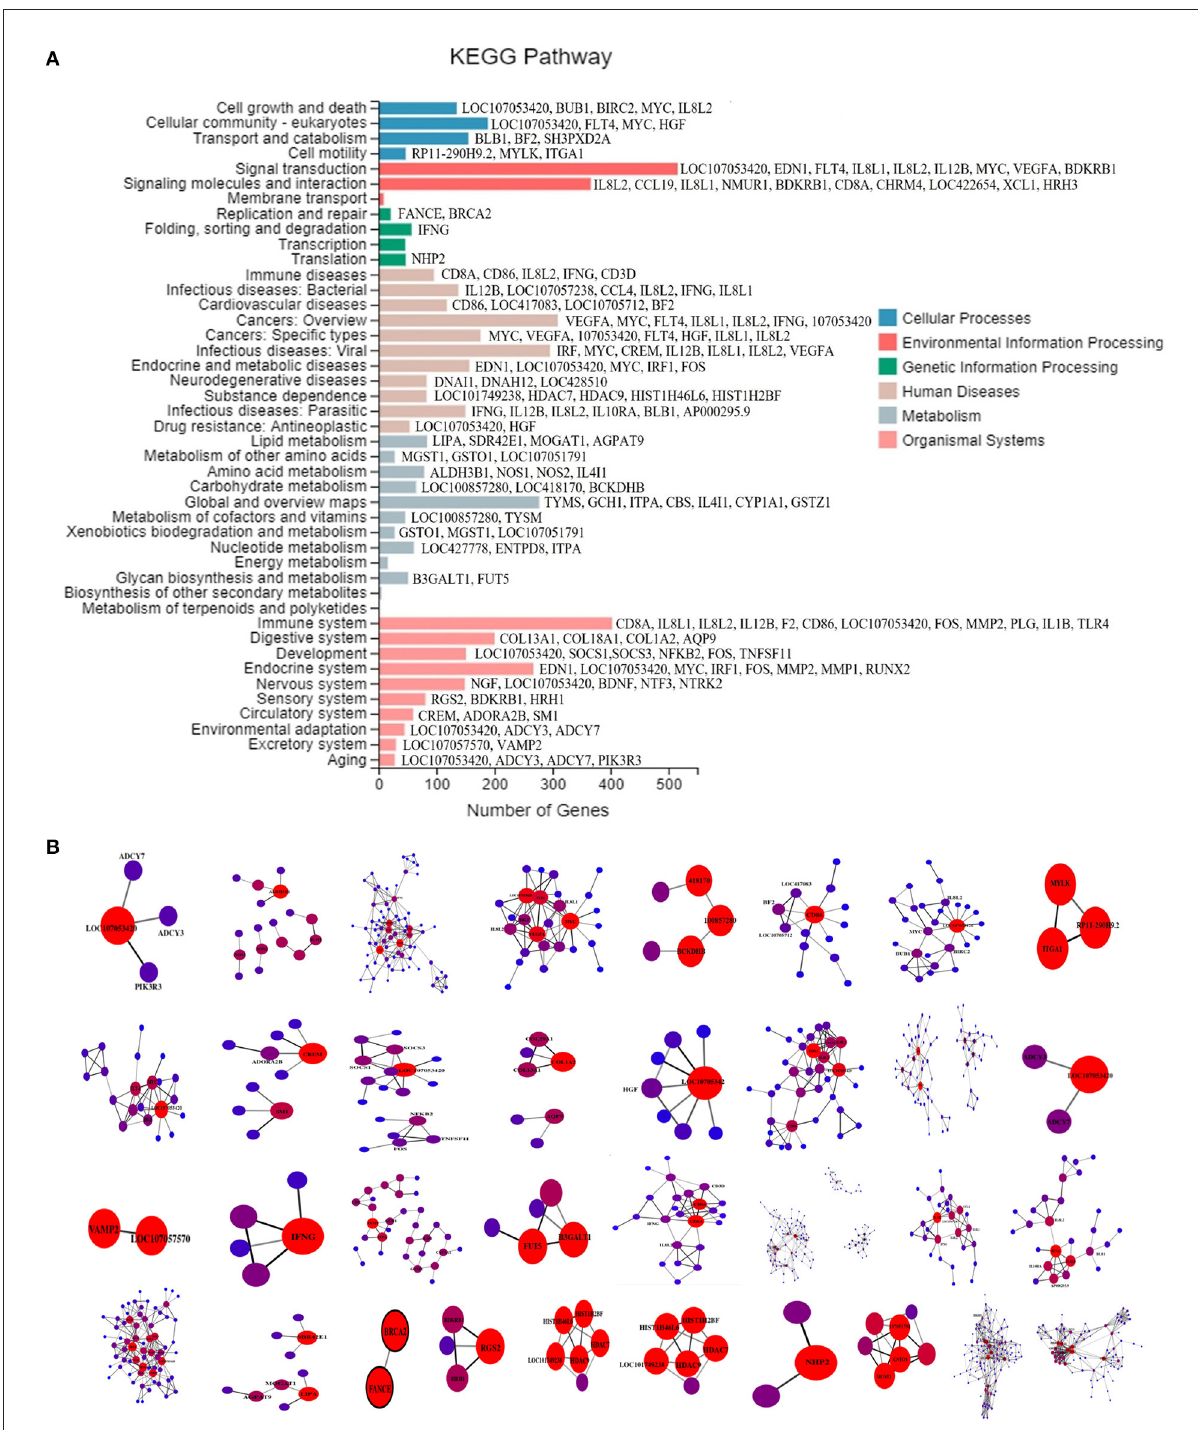
FIGURE1 (A) KEGG classification map of DEGs. KEGG categorization of the DEGs in the transcriptome of chicken lung induced by co-infection. The X-axis is the number of genes annotated to a KEGG Pathway classification, and the Y-axis is the KEGG Pathway classification. The gene symbols behind the histogram are the target genes screened by PPI. (B) PPI maps of DEGs in co-infection group. The Gene marked with Gene Symbol is the target Gene whose interaction relationship is > 300. The brighter the color is, the greater the node correlation and the stronger the interaction relationship